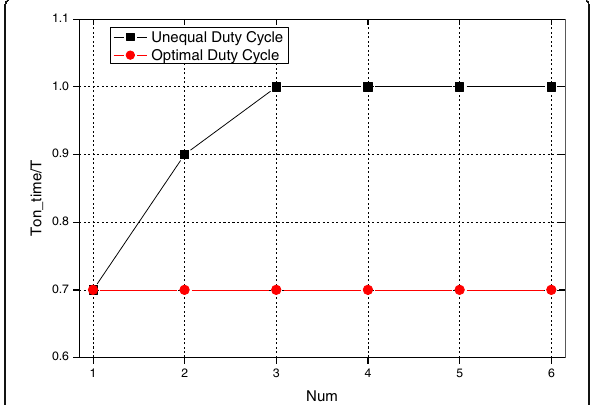
Fig. 11 The maximum energy consumption at optimal duty cycle under UDNP and EDNP